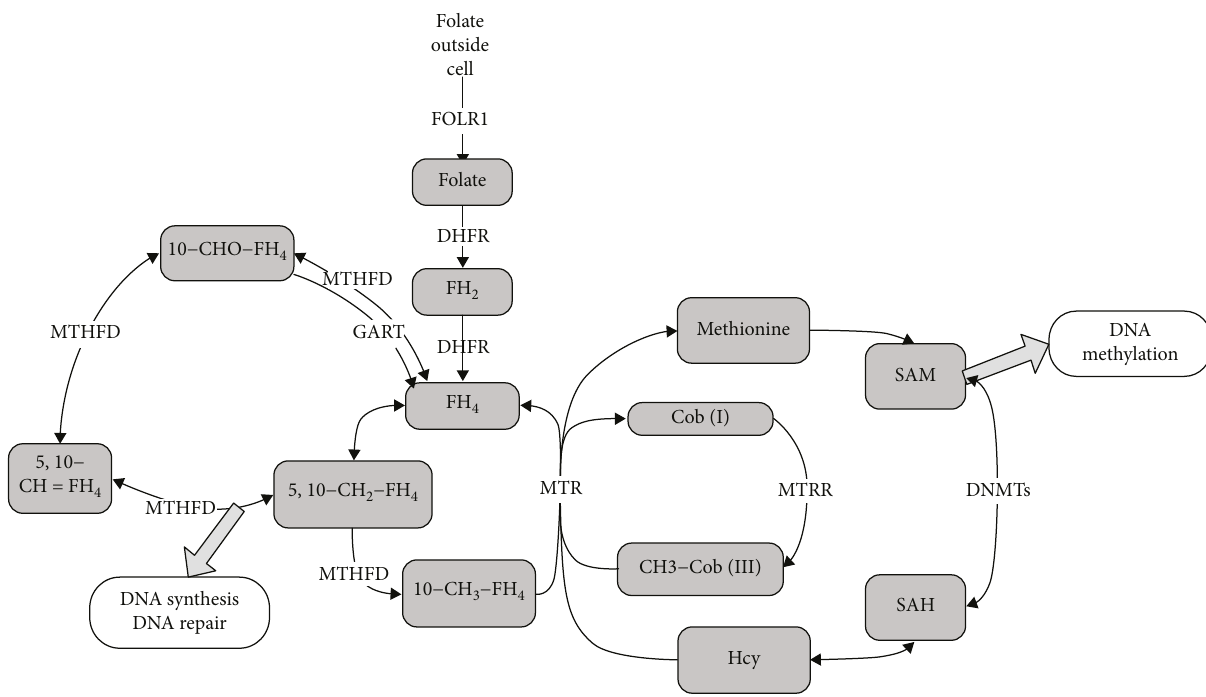
Figure 5: Schematic overview of the folate metabolic pathway mediated by FOLR, DHFR, and MTRR. Arrows that cross the line indicate metabolites that can travel between compartments. FOLR1: folate receptor 1; DHFR: dihydrofolate reductase; MTRR: methionine synthase reductase; MTR: methionine synthase; FH4: tetrahydrofolate; 5,10-CH2-FH4: 5,10-methylenetetrahydrofolate; SAM: S-adenosylmethionine; SAH: S-adenosylhomocysteine; Hcy; homocysteine; MTHFD: methylenetetrahydrofolate dehydrogenase; GART: phosphoribosylglycinamide formyltransferase; DNMTs: DNA